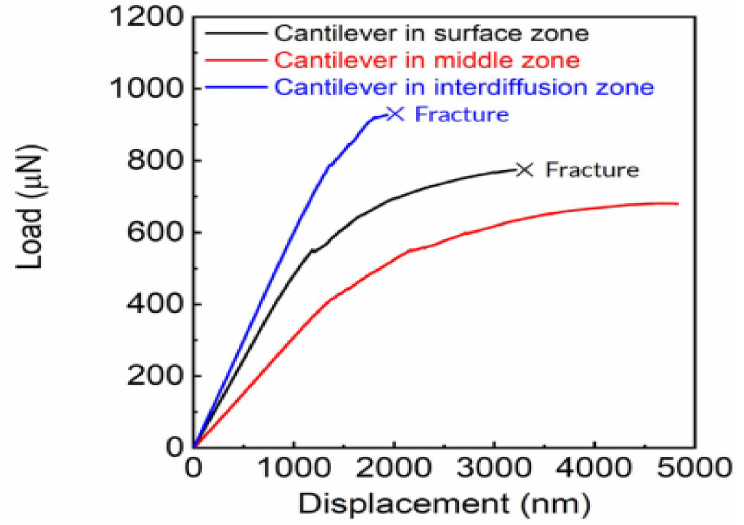
Figure 23. The load–displacement data of cantilevers in the surface zone, the middle zone, and the interdiffusion zone [14].